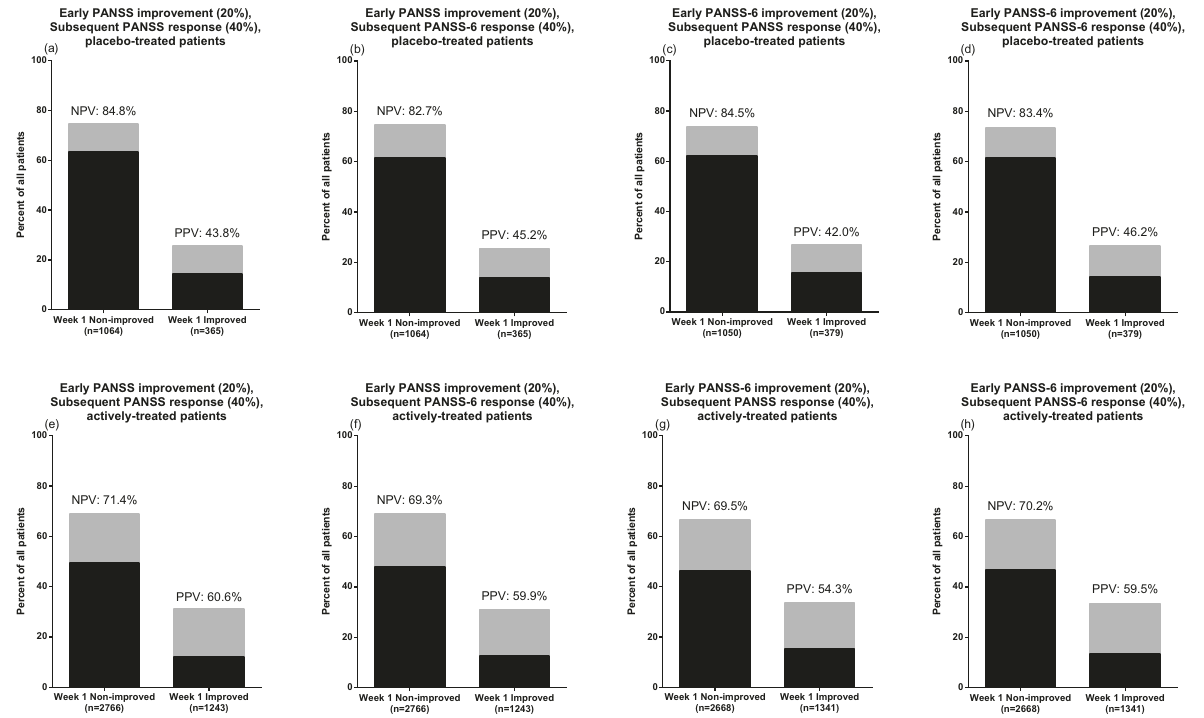
Fig. 1 Positive and negative predictive value of early improvement on subsequent response. NPV negative predictive value, PPV positive predictive